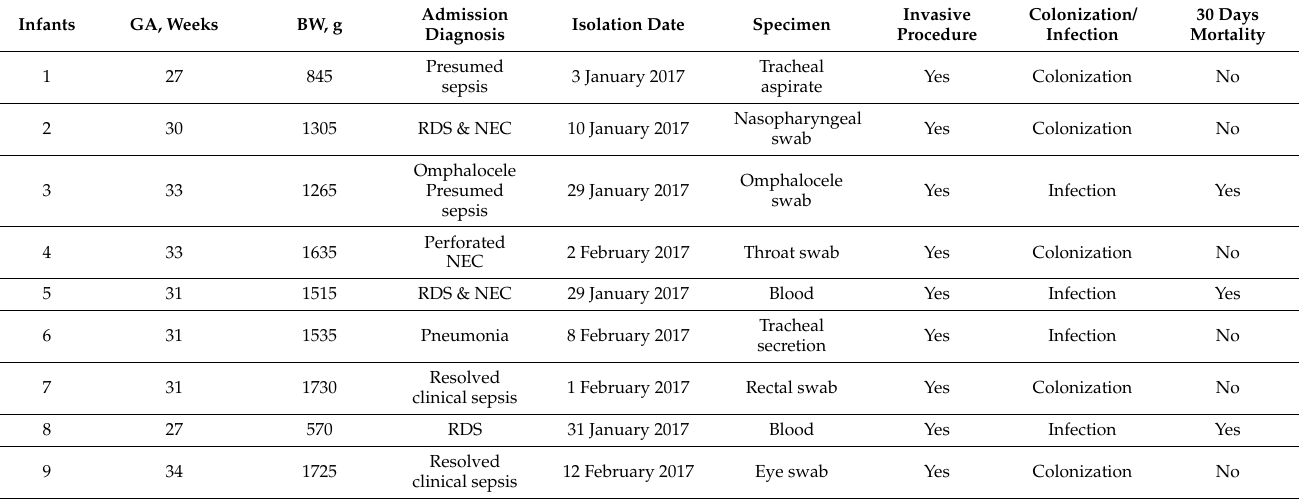
Table 1. Line listing of 9 neonates involved in the outbreak.